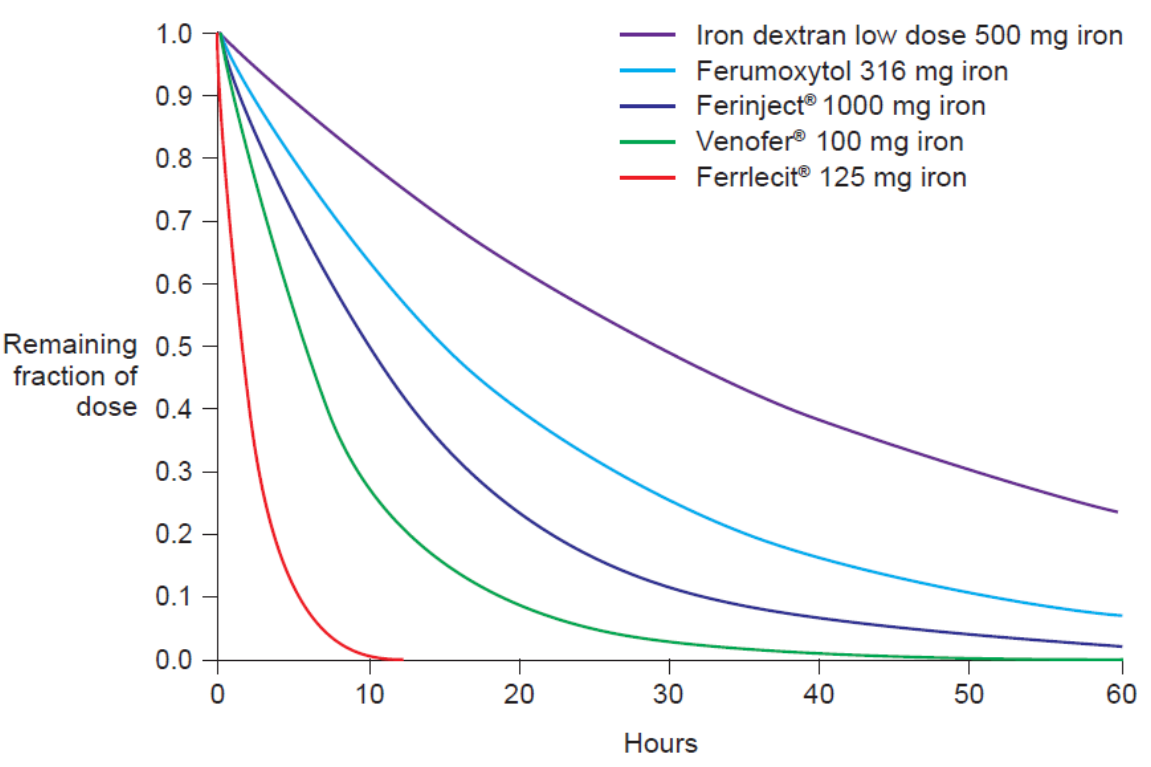
Figure 3. Normalized simulated single first-order elimination kinetics for different intravenous iron preparations, depicted as fraction of total serum iron over time. Values of the terminal elimination rates given in Table 2 were used to calculate an overall first-order kinetics and t values. The figure clearly shows that the AUC is negatively correlated to 1/2 the elimination rate